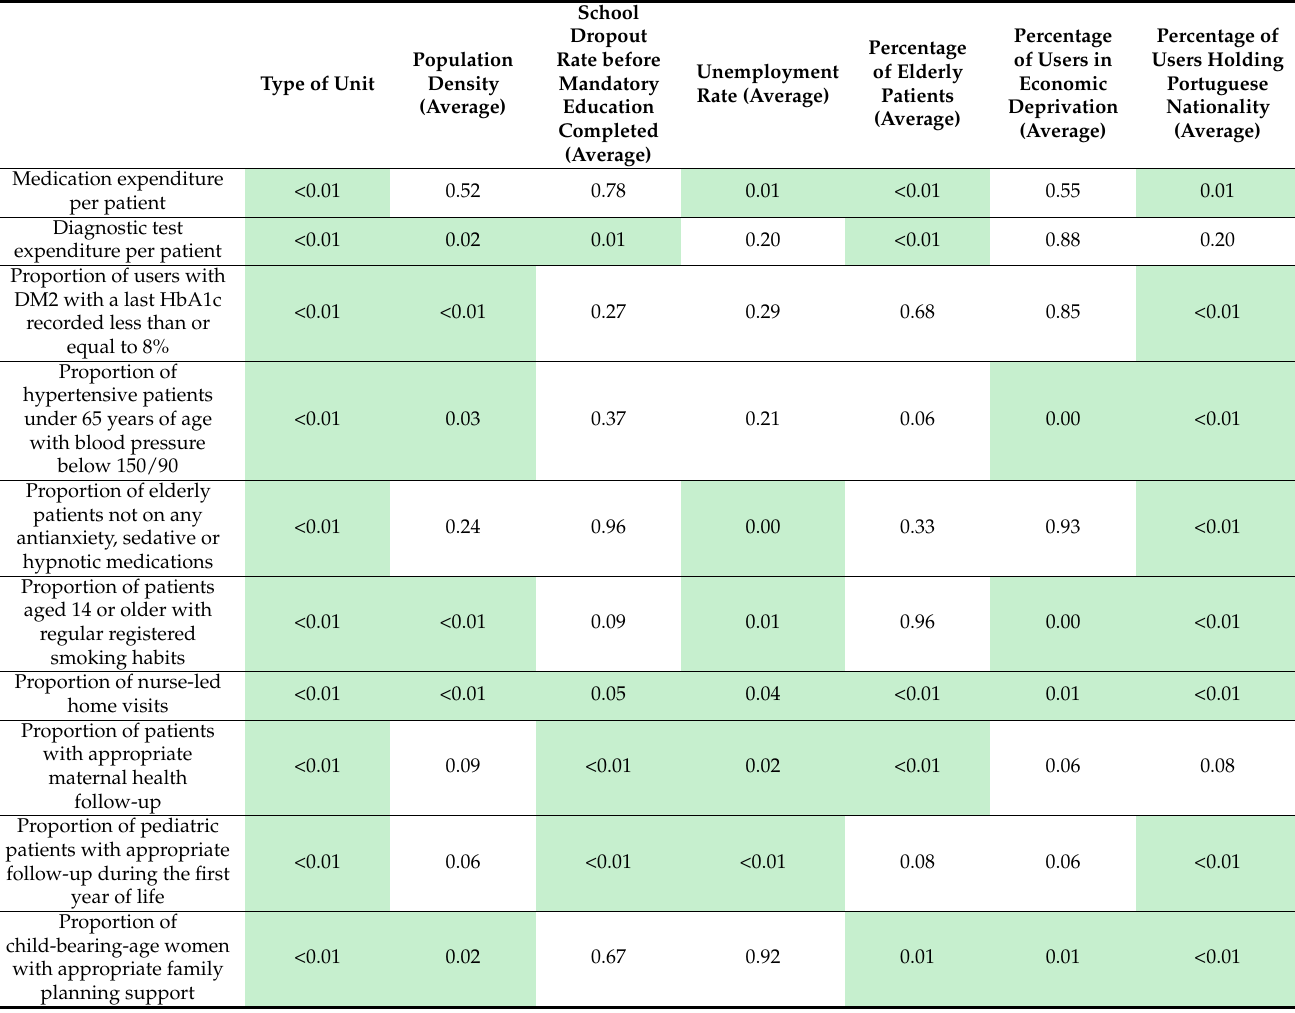
Table 2. Relationship between context factors and evolution of the PHC indicator results ( p -value).